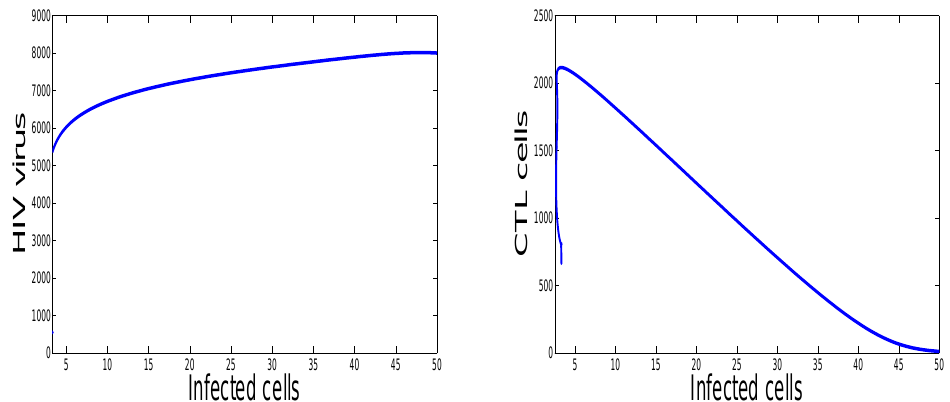
Figure 7. Selective phase portraits to illustrate the solution behavior of the infection dynamics when λ = 10, d 1 = 0.0139, k 1 = 0.04, d 2 = 0.0495, k 2 = 1.1, d 3 = 0.5776, a = 100, d 4 = 0.6, p = 0.0024, c = 0.15, b =